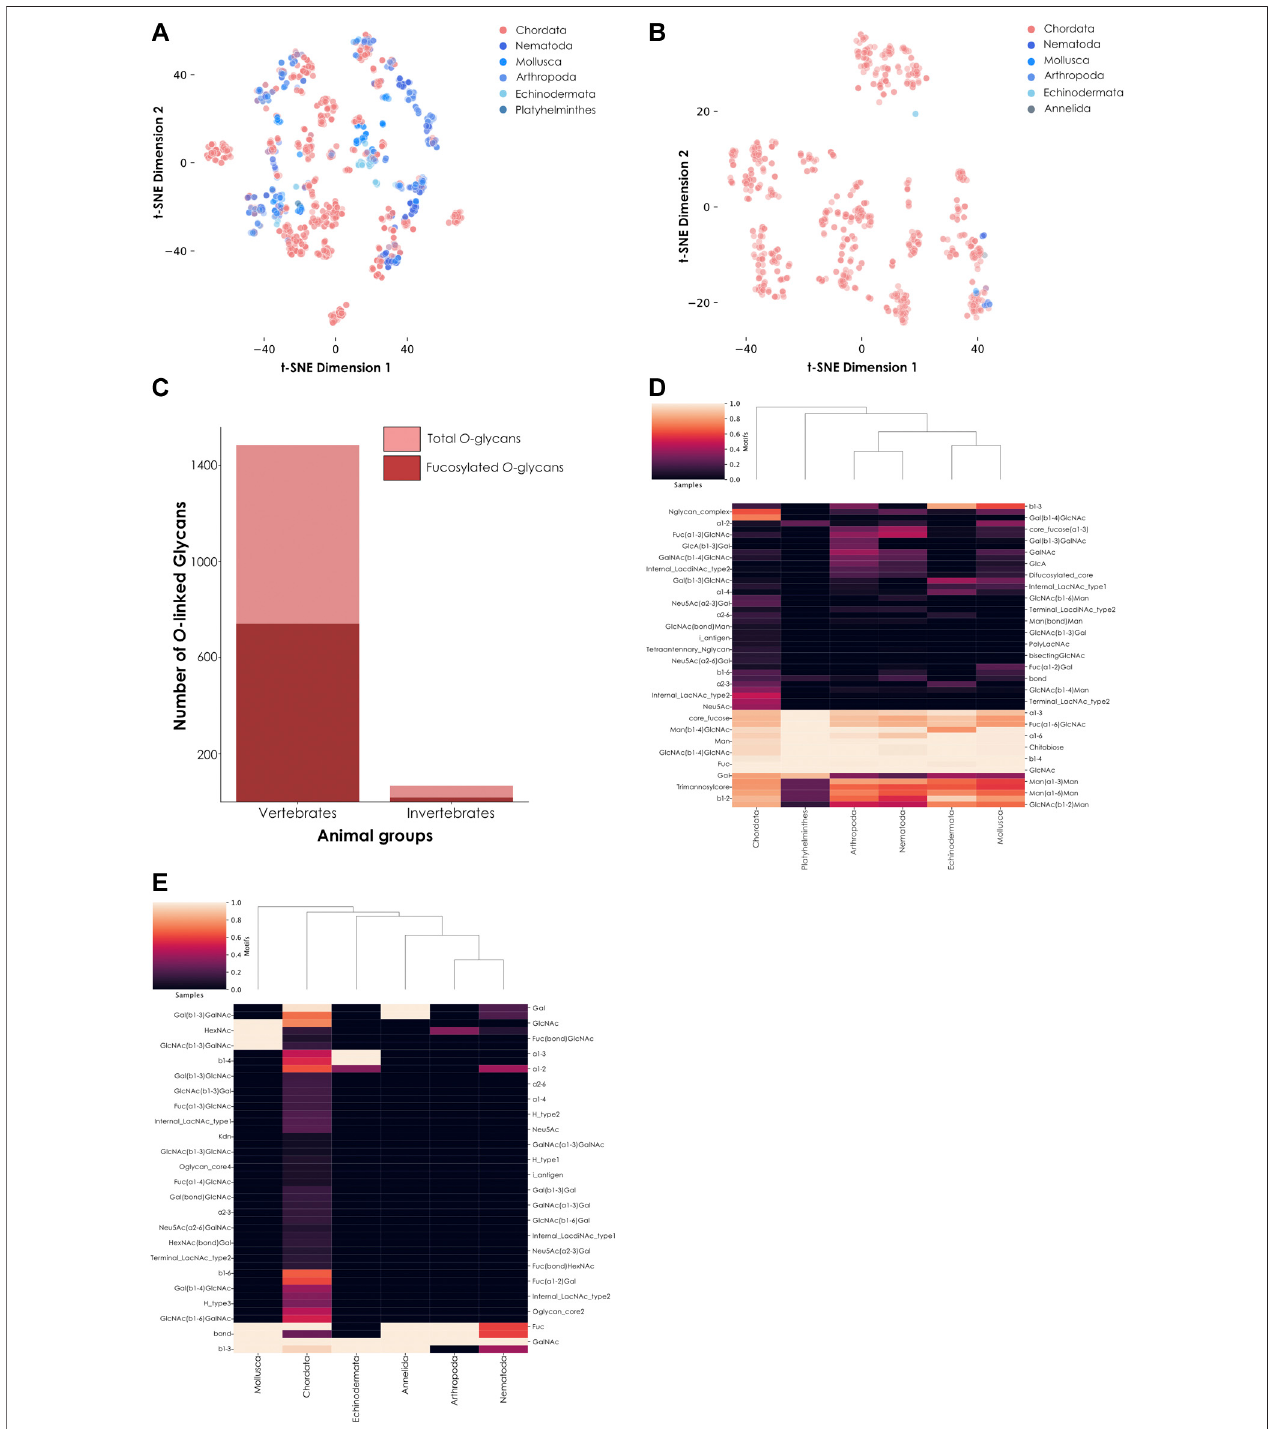
FIGURE3| Comparisonoffucosylated N -linkedand O -linkedglycansfromvertebratesandinvertebrates. (A) Fucosylated N -linkedglycansfromanimals.Glycans are represented via t-SNE as colored dots, based on their learned similarity from a SweetNet model. Colors indicate the phylum from which they stem. (B) Fucosylated O -linked glycans from animals. Similar to (A) , glycans are visualized via their learned similarities and colored according to their phyla. (C) Number of total versus fucosylated O -linked glycans. Bar graph comparing the number of total versus fucosylated O -glycans from vertebrate and invertebrate species. (D) Heatmap of fucosylated N -linked glycans from animals. This heatmap represents the relative abundance of different motifs from fucosylated vertebrate and invertebrate N -glycans. (E) Heatmap of fucosylated O -linked glycans from animals. Similar to (D) , the relative abundance of different motifs from fucosylated vertebrate and invertebrate O -glycans is shown on a